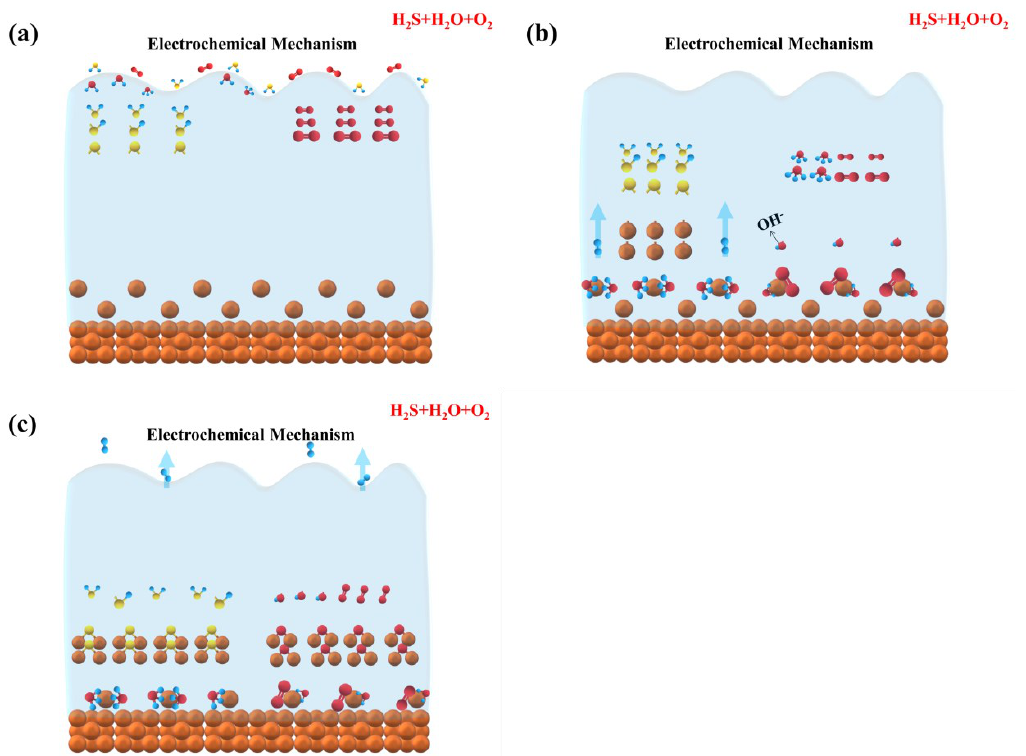
Figure 14. Schematic diagram of corrosion steps of copper sheet in LPG with H 2 S + H 2 O + O 2 . ( a ) step1. ( b ) step2. ( c ) step3.